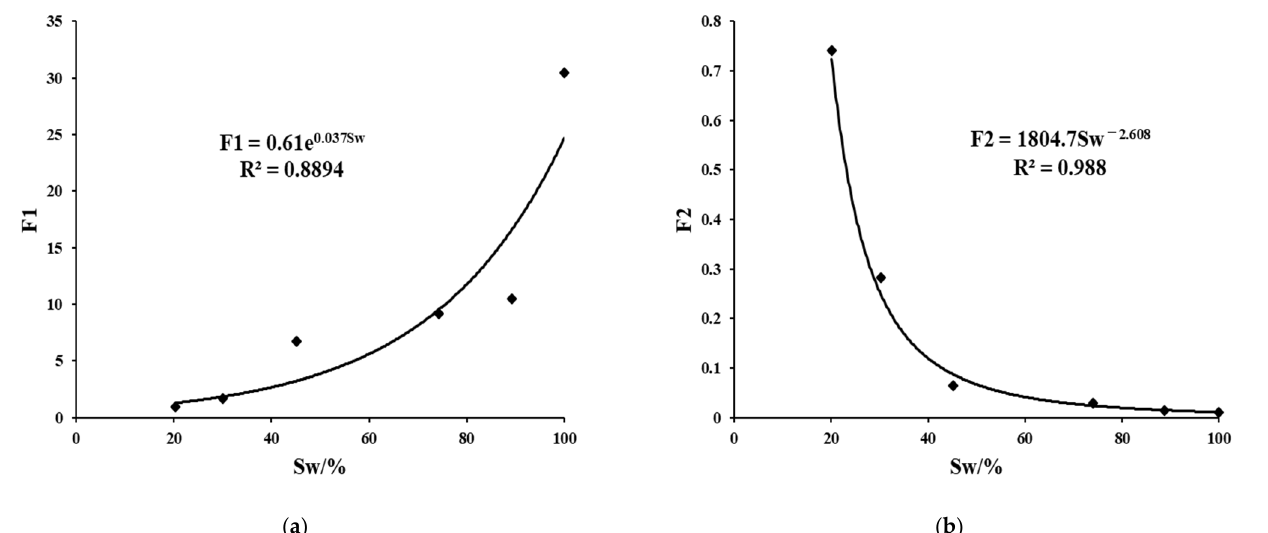
Figure 25. Relationship between weight coefficient and water saturation: ( a ) relationship between weight coefficient F1 and water saturation; ( b ) relationship between weight coefficient F2 and water saturation.